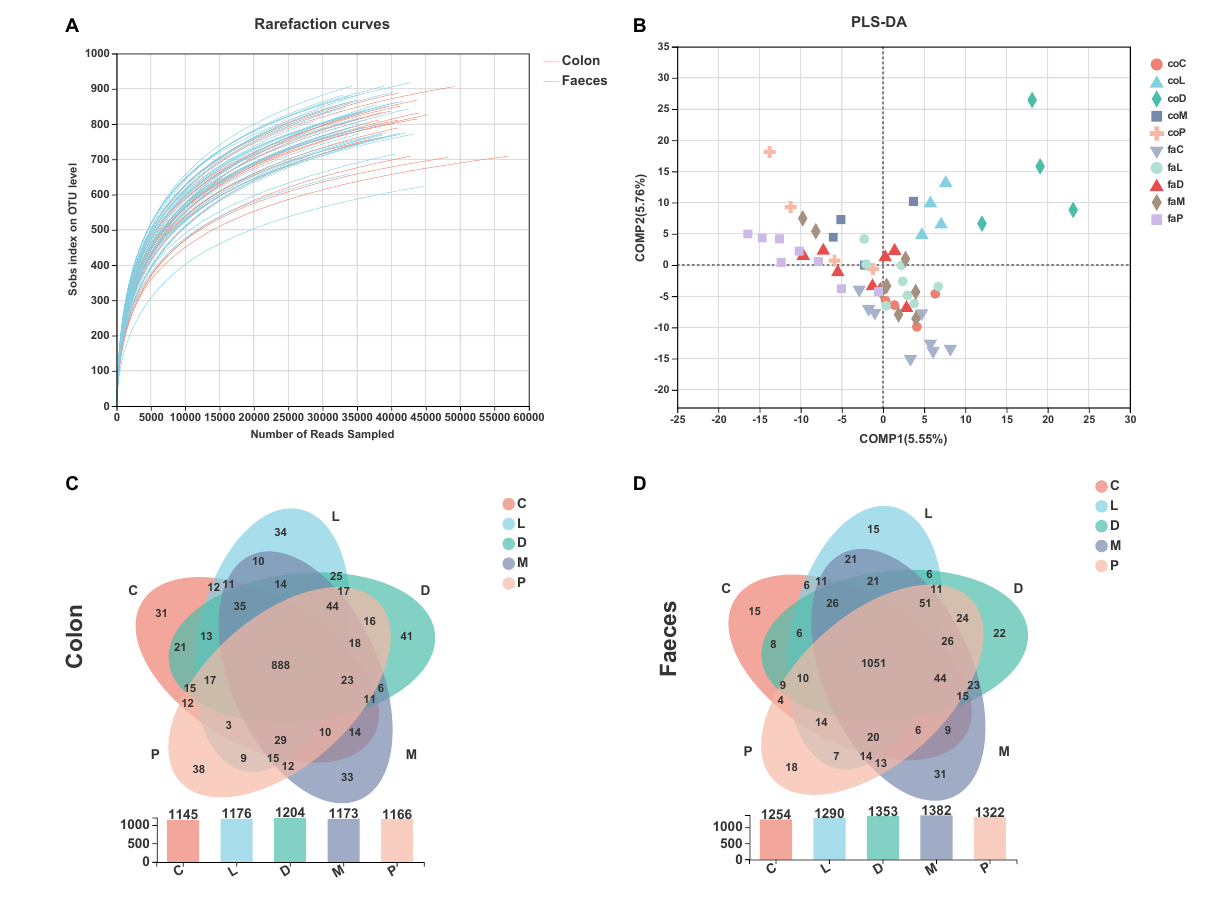
FIGURE 3 | Bacteria richness and OTU composition analysis. (A) Rarefaction curves of observed bacterial sequences in the colonic contents and feces of piglets. (B) Partial least squares-discriminant analysis (PLS-DA) of colonic digestive and fecal bacterial community. (C) Venn diagram of the OTUs in the colon by different treatments. (D) Venn diagram of the OTUs in the feces by different